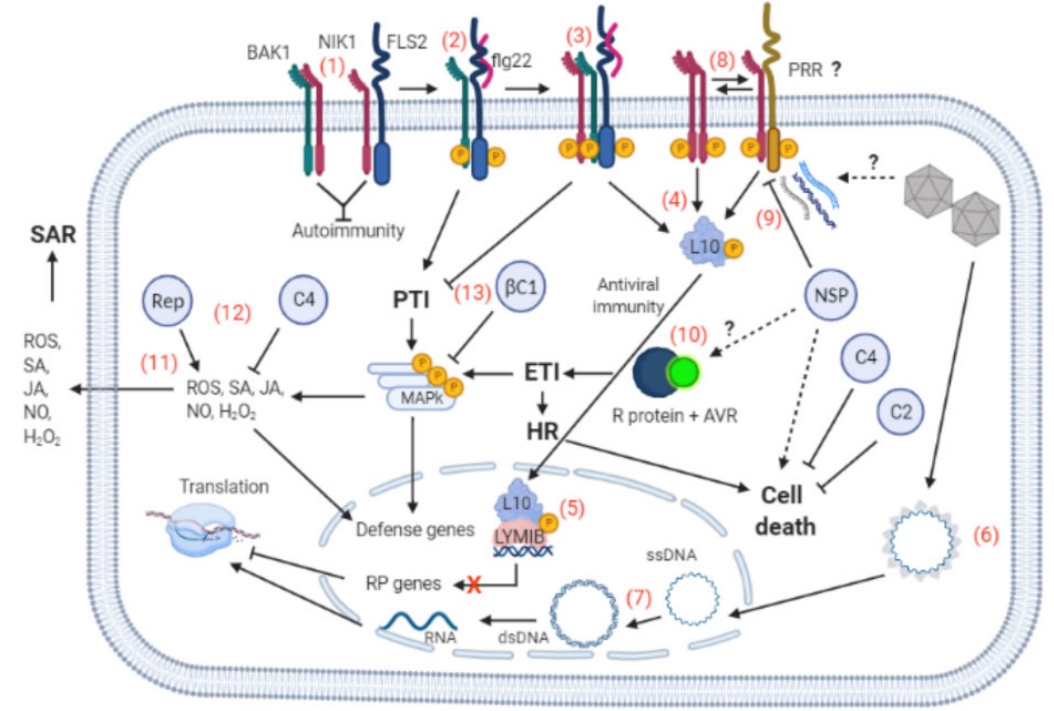
Figure 3. Antiviral innate immunity, interactions with viral suppressors and bacterial PTI (1). Under normal, resting conditions, NSP-interacting kinase 1 (NIK1) is bound to the flagellin receptor FLS2 (Flagellin-sensitive 2) and coreceptor BAK1 (Brassinosteroid insensitive 1-associated receptor kinase 1) to prevent autoimmunity. (2) Upon bacterial infection, the bacterial PAMP (pathogen-associated molecular pattern) flg22 is sensed by FLS2, inducing its oligomerization with BAK1, which results in phosphorylation-mediated activation of the immune complex to initiate PAMP-triggered immunity (PTI), activating the mitogen-activated protein kinase (MAPK) cascade and inducing defense genes. (3) Activated BAK1 also phosphorylates NIK1 at Thr-474, which in turn inhibits further PTI (4) and activates the NIK1-mediated antiviral signaling pathway, mediating ribosomal protein 10 (RPL10) phosphorylation. (5) Phosphorylated RPL10 is translocated to the nucleus, where it interacts with L10-interacting Myb domain-containing protein (LIMYB) to repress protein ribosomal (RB) genes and translational factors, suppressing global translation. (6) In infected cells, the geminivirus particles are disassembled in the cytoplasm and the CP-viral ssDNA complex is directed to the nucleus where (7) the viral ssDNA is converted into dsDNA for replication and transcription of the viral genome. (8) Begomoviruses-derived nucleic acids also function as viral PAMPs inducing NIK1 dimerization with itself or an unidentified viral PAMP recognition receptor (PRR) to transduce the antiviral signal that culminates in translational suppression. Then, viral mRNA is not efficiently translated impairing infection. (9) The begomovirus nuclear shuttling protein (NSP) counters the activation of this defense pathway by binding to the NIK1 kinase domain and, hence, prevents phosphorylation and transduction of the antiviral signal that otherwise would impair infection. (10) In resistant genotypes, NSP may also function as an avirulence (AVR) factor to activate effector-triggered immunity (ETI) via resistance (R) protein recognition, inducing hypersensitive response (HR) and cell death. (11) The PTI and ETI products (ROS, SA, JA, NO, H 2 O 2 ) can induce defense genes and systemic acquired resistance (SAR). Geminivirus suppressors of innate immunity include (12) C4 that inhibits PTI by interacting and inhibiting FLS2 and along with Rep inhibits SA- and ROS-dependent signaling; C4 and C2 inhibit HR and cell death. (13) Furthermore, the betasatellite β C1 inhibits the MAP kinase cascade. The question marks indicate either events not well clarified or unknown. See Figure 1 for the designations of the viral proteins. The figure was created with